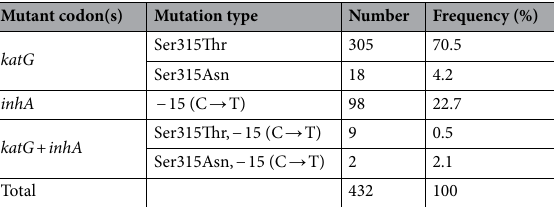
Table 3. The katG and inhA gene mutations of 320 INH-resistant Mtb strains.